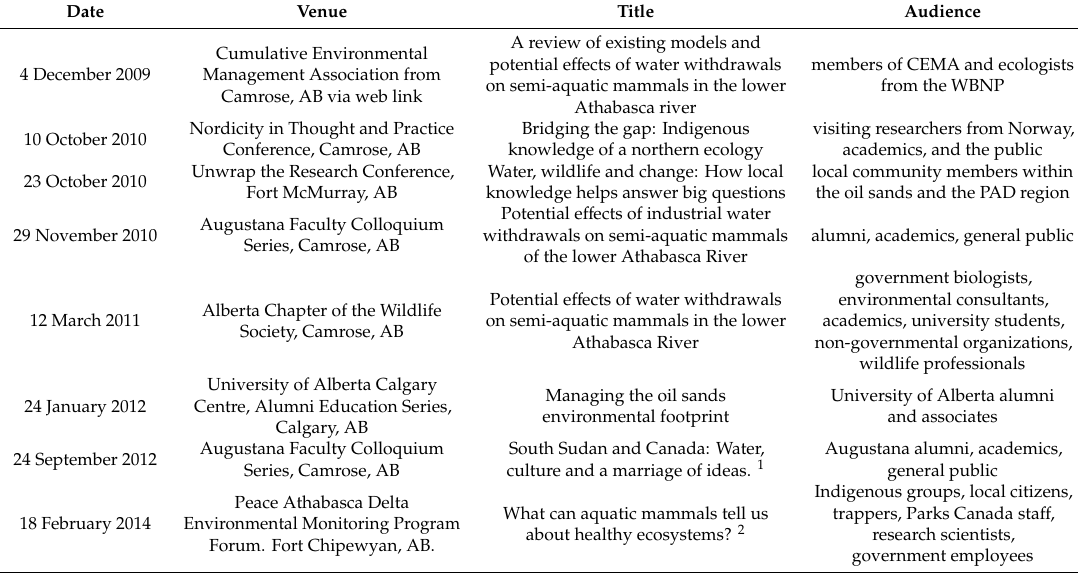
Table 3. Presentation of research beyond academia (2010 to